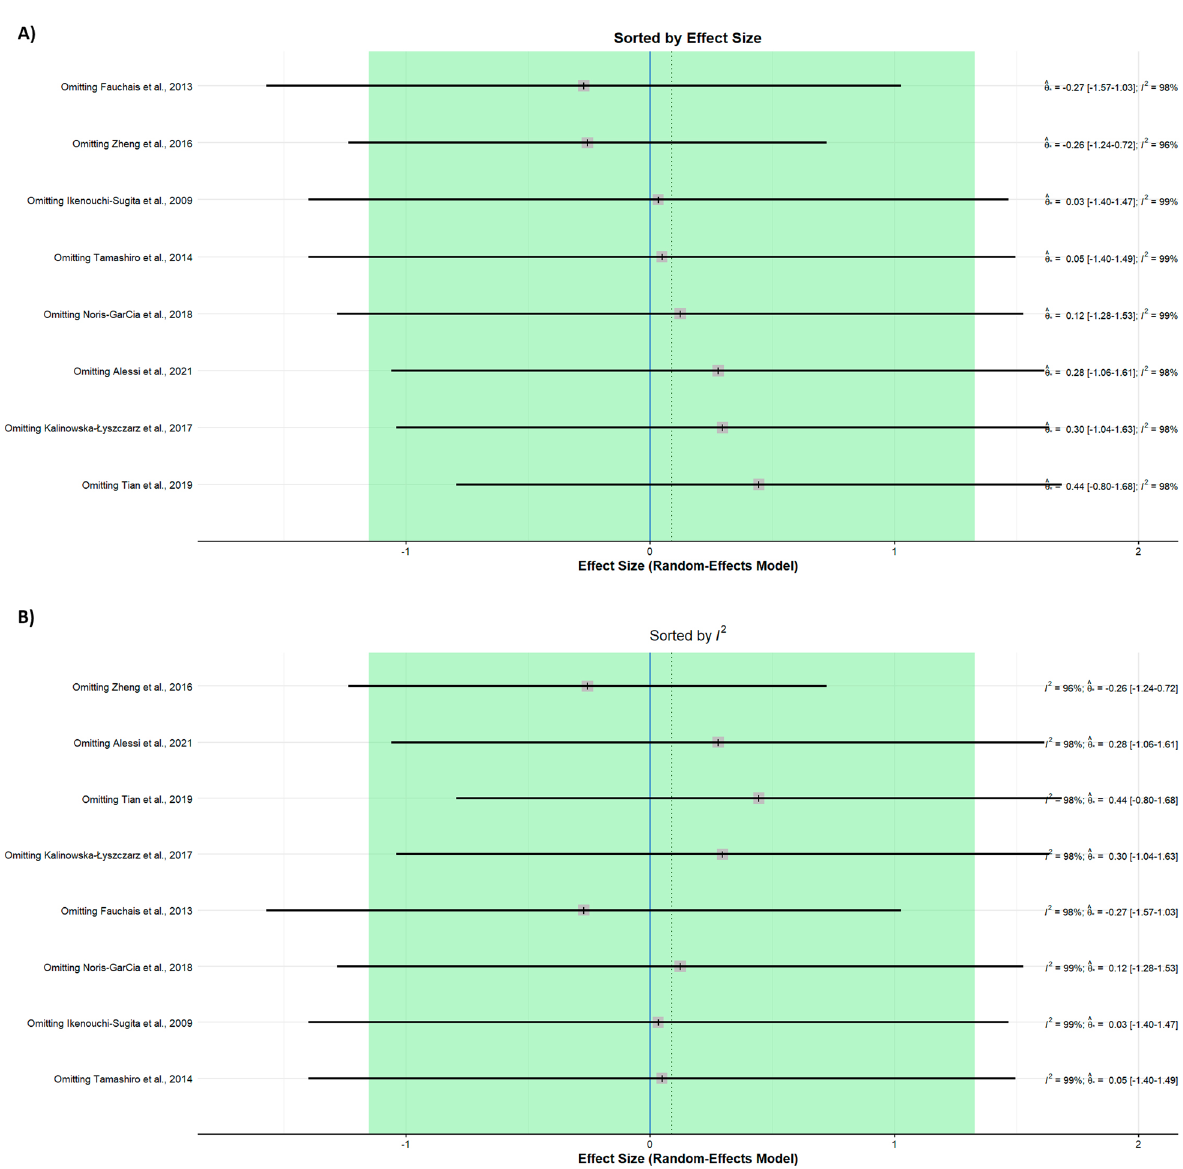
Fig. 4 Results of Sensitivity analysis (leave-one-out analysis) of the meta-analysis A Sorted by I 2 ; B Sorted by Effect